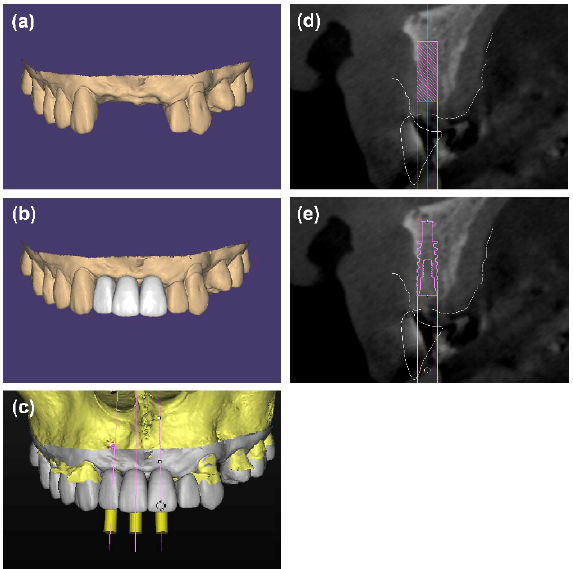
Figure 1. ( a – d ) 3.5 mm diameter and 10 mm-length virtual implants were placed in a prosthetically ideal position under the guidance of the diagnostic wax-up. ( e ) The 3.5 mm diameter and 10 mm- length virtual implants were replaced with specific virtual implants of the proper size to fabricate the surgical guide plate for implant placement.